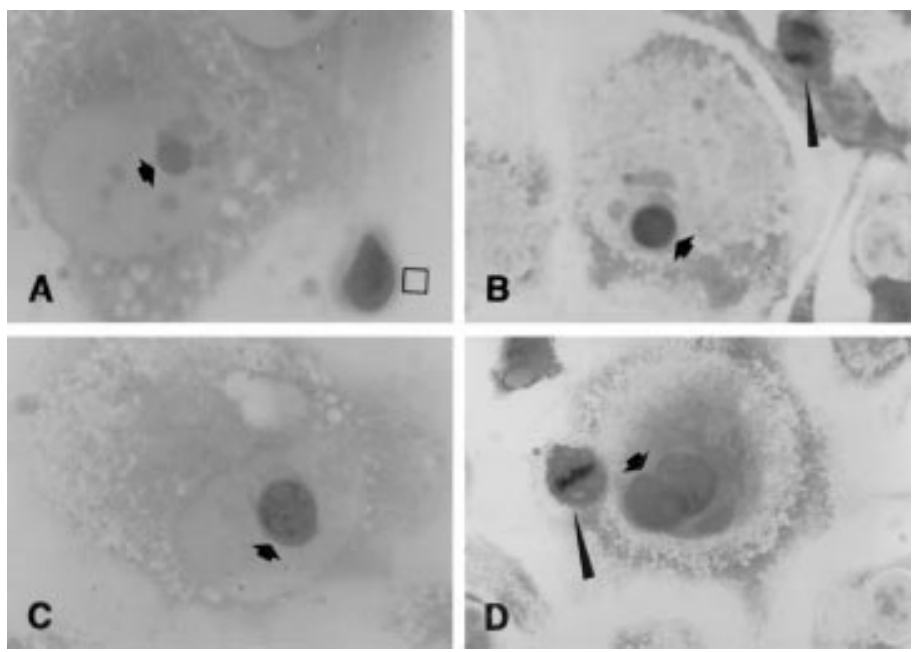
Fig. 1. Appearance of microcells in a macrocell nucleus. A – rounded collection of fine grain material forming the outline of a microcell in the macronucleus. B, C – a microcell in the macronucleus. D – a cluster of microcells in the macrocell. Thin arrows point to metaphase microcells. Thick arrows point to microcells in the macronucleus. Square – a microcell in the intercellular space. Methyl green-pyronine. Obj. 90 (cid:2) , oc. 7 (cid:2)